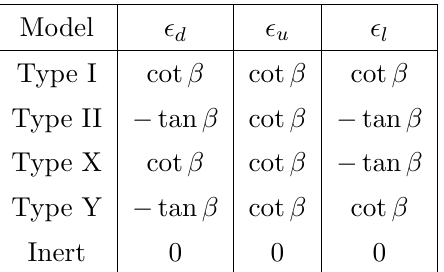
correspond to one of the Z symmetric Yukawa structures (type I, II, X or Y), as 2